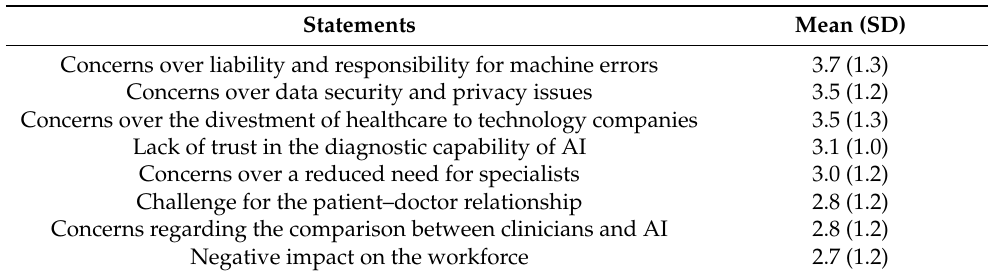
Table 3. The concerns over the use of AI in dentistry according to 302 as rated on a 5-point Likert scale. 1: a little concerning; 5: highly